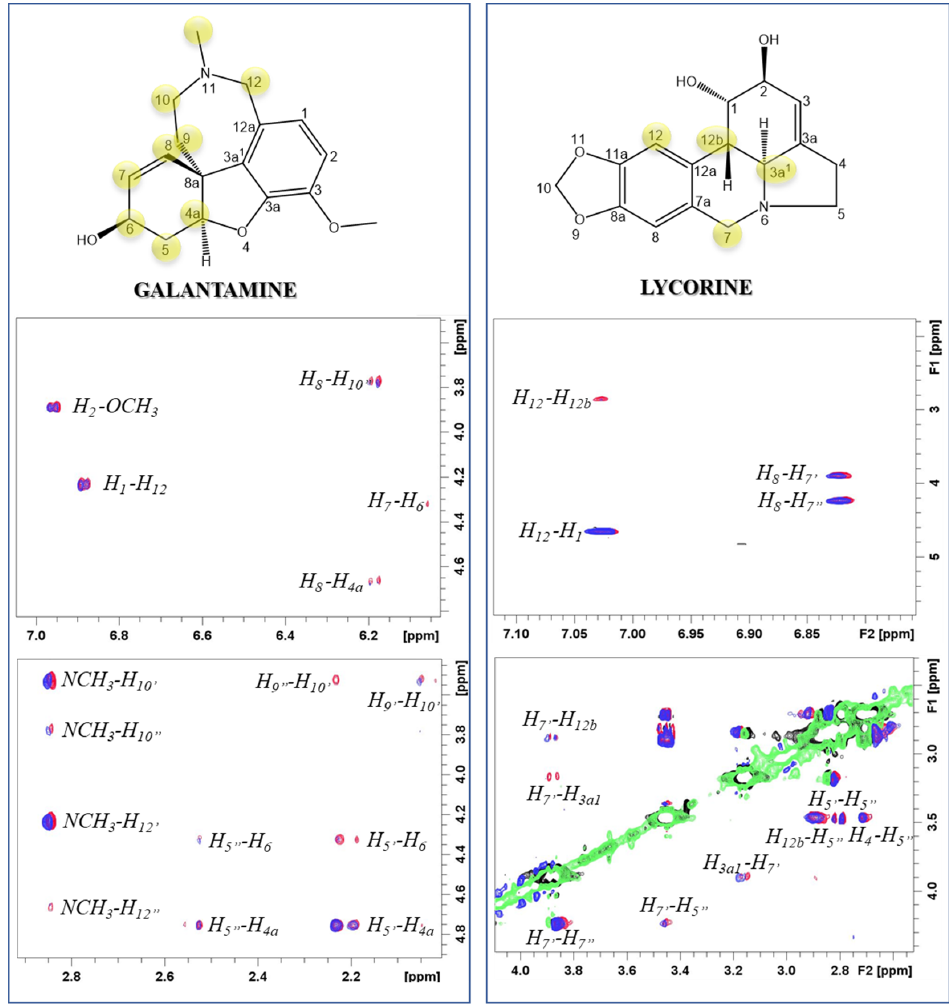
Figure 2. Selected regions of 1 H- 1 H NOESY spectra of GAL ( left ) and LYC ( right ) in absence (red contours) and in presence of 0.3 equivalent (eqs.) of A β 40 (blue contours). Alkaloid concentration 0.25 mM, A β 40 concentration 0.083 mM, phosphate buffer 20 mM, pH 7.5, T = 298